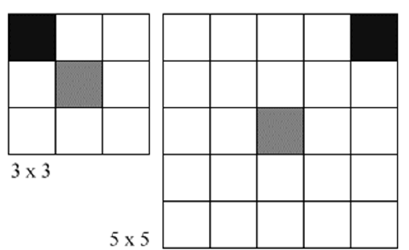
Figure 4 . Example of position of the highest value (black) in a 3 × 3 and 5 × 5 moving window. Centre of the window in